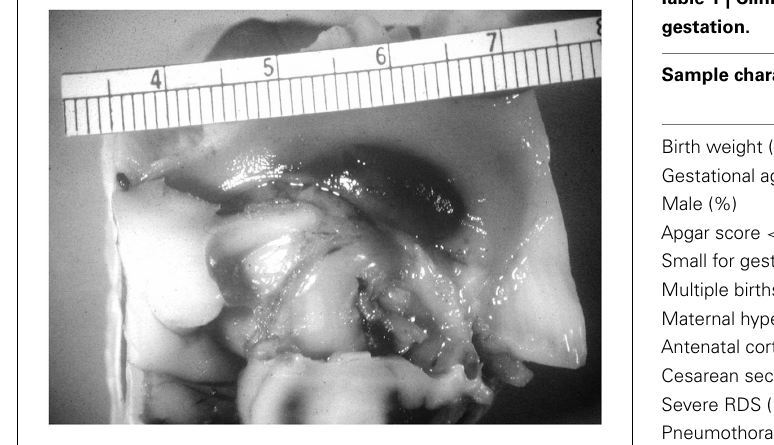
FIGURE 1 | Unruptured germinal matrix hematoma . Photograph courtesy of Kevin Bove, and A. James Mc Adams (deceased), Department of Pathology, Cincinnati Children’s Medical Center.